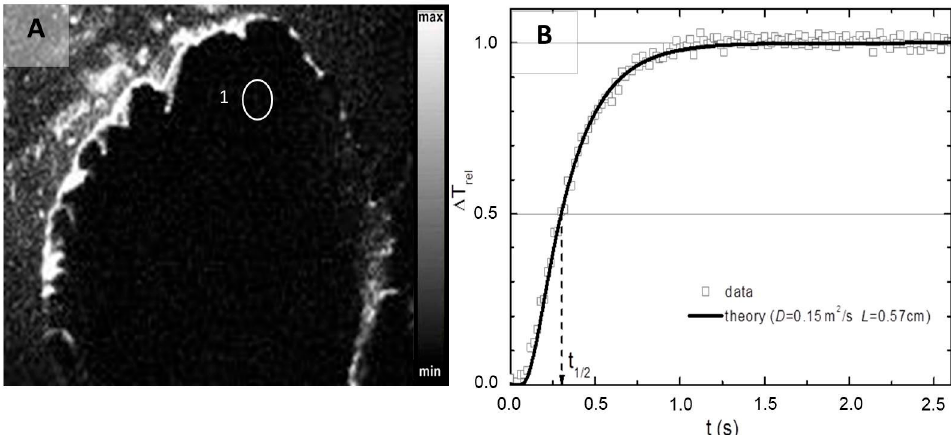
Figure 5. ( A ) Thermogram obtained at the She Wolf right ear. The label indicates the spot in which the time dependence of the radiometric signal, displayed in Figure 5B, was analyzed; ( B ) time dependence of the thermographic data obtained by rear face heating in zone 1 of the right ear. The continuous line represents the theoretical results obtained with L = 0.57 cm and D = 0.15 cm 2 /s. The vertical dashed line intercepts the t 1/2 value [48,49].